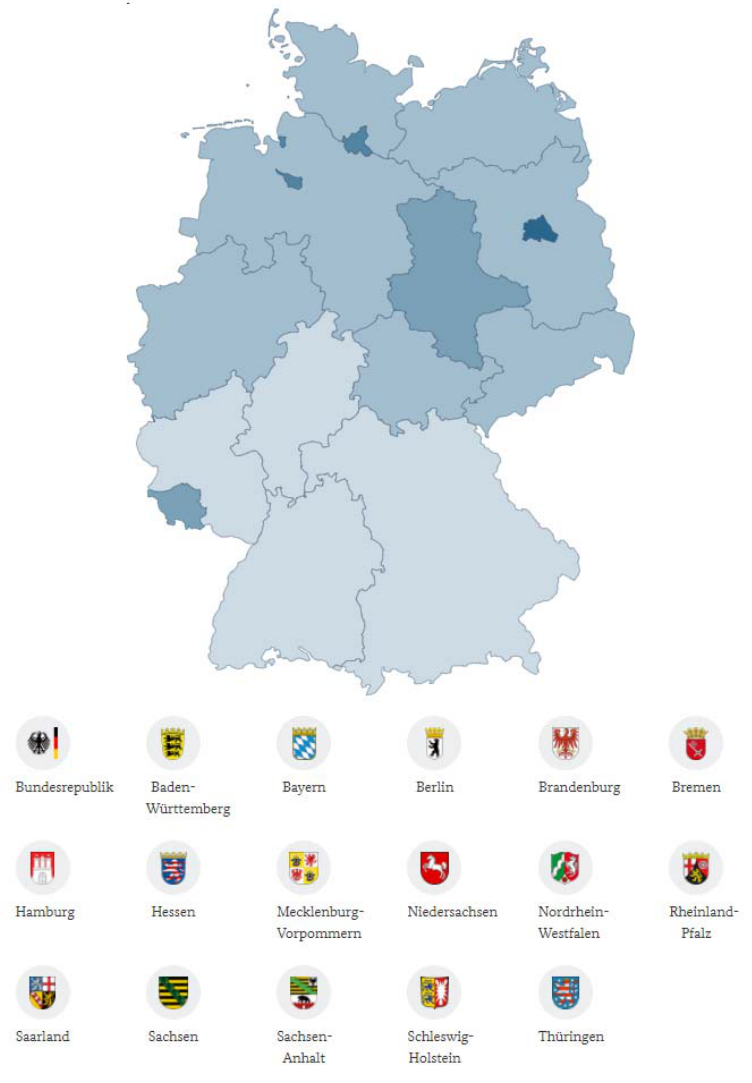
Figure 7. Interactive map of Germany - initial display of crime rate [15]